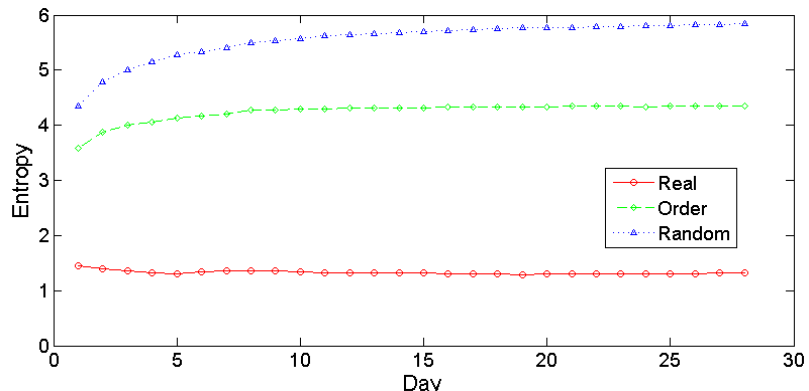
Figure 11. The plot for the trend of average entropy with